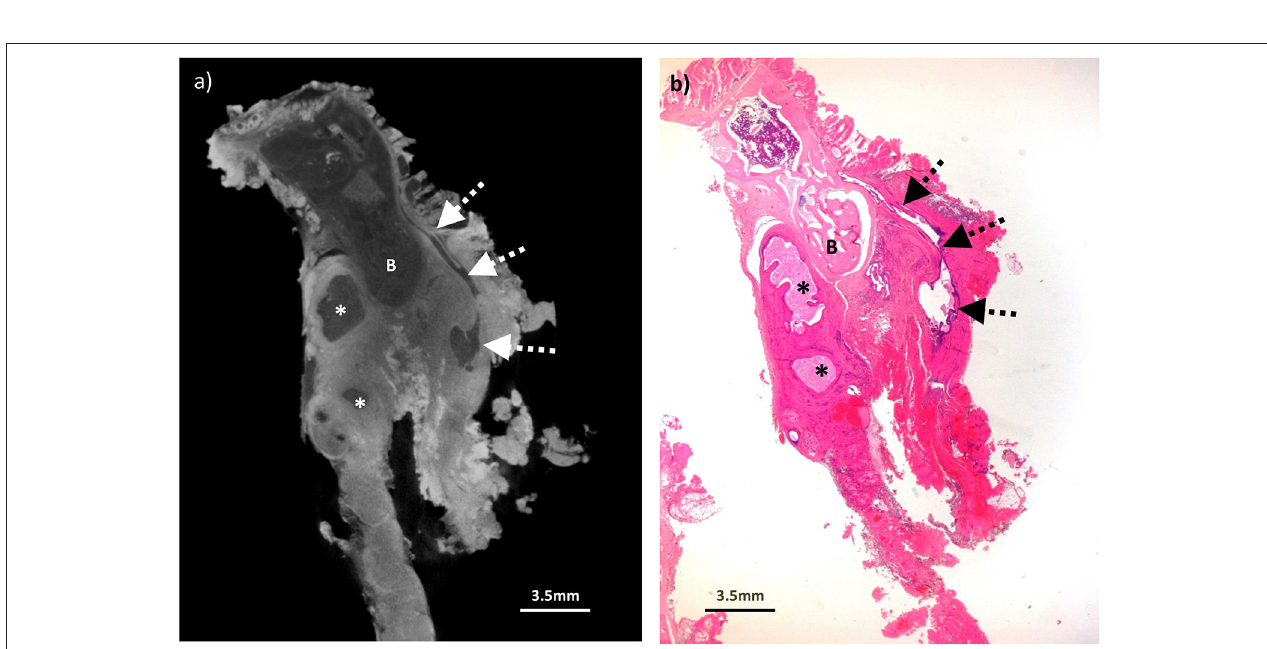
FIGURE 5 | Excised thyroglossal duct cyst specimen from a 14-year old female patient (case 5). (a) Paired iodinated micro-CT imaging at 22.2 micron resolution and (b) histopathological section with H&E staining demonstrate the thyroglossal duct (dashed arrows) anterior to the hyoid bone (B) with areas of cystic change (remnants) from a previously infected and ruptured cyst